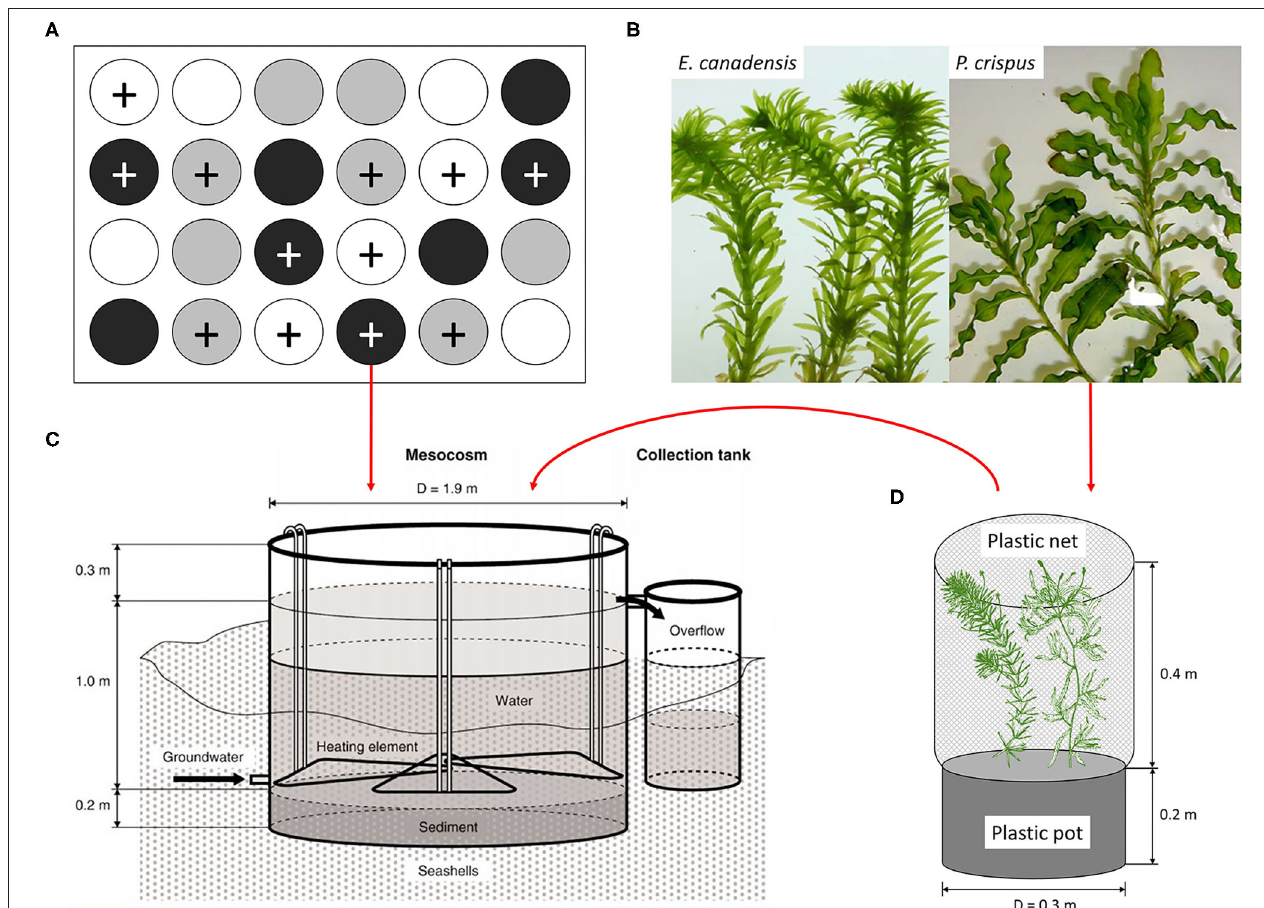
FIGURE 1 | (A) Diagram of the experimental design, (B) the experimental plant materials, (C) the mesocosm tank equipped with a flow-through system, and (D) the plastic pot planted with two individual plants, based on Liboriussen et al. (2005) and Trochine et al. (2014). The experimental design includes 24 tanks with two nutrient levels, unenriched (no symbol) and enriched ( + symbol), and three temperature scenarios, ambient (white), warming (gray), and enhanced warming